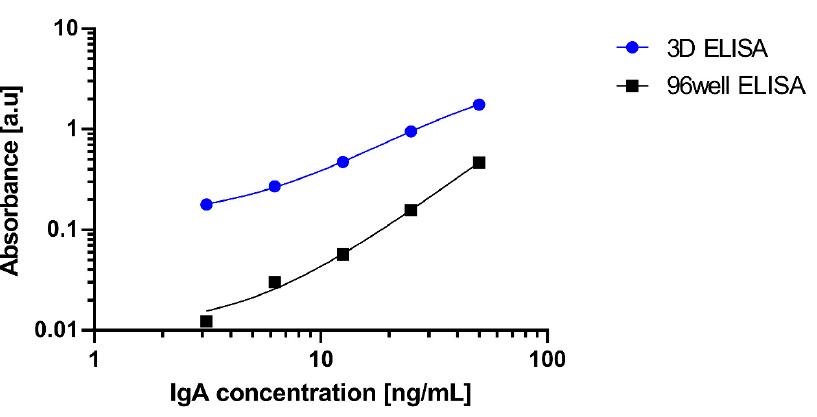
Figure 15. Calibration curve for ELISA of IgA using 96 well and 96 well with 3D-Stack. Table 1. Comparison in detection and quantification limits and process time for ELISA.